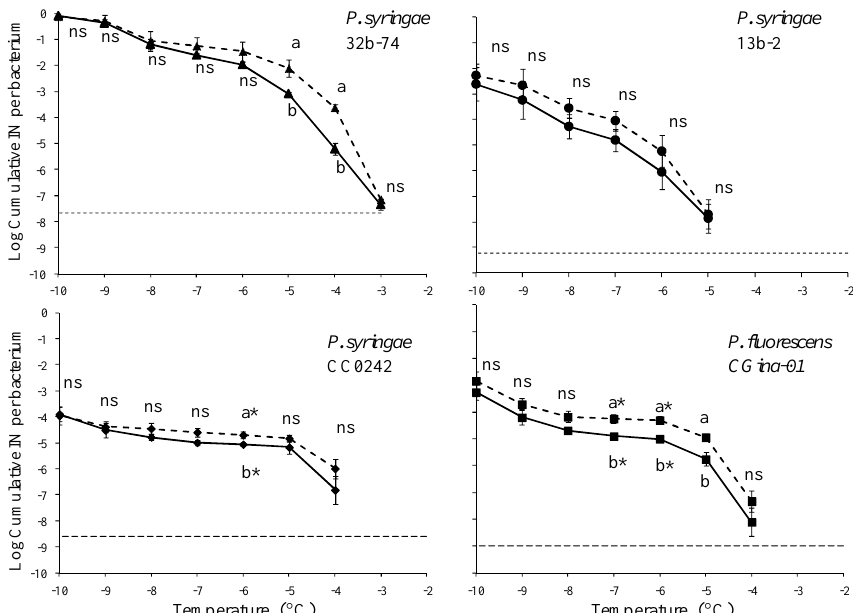
Fig. 5. Ice nucleation spectra of Pseudomonas strains submitted to 42h of UV-A exposure (solid line) or darkness (dotted line). The horizontal line corresponds to the lowest value of detectable activity, which depends on the initial bacterial concentration of each experiment. Symbols Figure 5: Ice nucleation spectra of Pseudomonas strains submitted to 42 h of UV-A exposure 3 are as in Fig. 1. INA was calculated by dividing the number of ice nuclei (IN) recorded after 42h of UV-exposure by the viable cell number counted at the beginning of the experiment. At each temperature, values associated with different letters are significantly different at p < 0.05 (solid line) or darkness (dotted line). The horizontal line corresponds to the lowest value of 4 and those associated with an asterisk are significantly different at p < 0.1 based on Tukey’s test. ns: no significant treatment effect. Errors detectable activity, which depends on the initial bacterial concentration of each experiment. 5 bars are standard errors ( n = 4). Symbols are as in Figure 1. INA was calculated by dividing the number of ice nuclei (IN) 6 living bacteria but also on the INA of the non-viable bac- recorded after 42 h of UV-exposure by the viable cell number counted at the beginning of the 7 terial product Snomax r , thereby supporting the hypothesis experiment. At each temperature, values associated with different letters are significantly 8 that acidic pH affects the INA of bacteria probably by di- rectly changing the ice nucleation protein structure. How- different at p<0.05 and those associated with an asterisk are significantly different at p<0.1 9 ever, the effects of acidic pH were less intense on Snomax r based on Tukey’s test. ns: no significant treatment effect. Errors bars are standard errors 10 than on living bacteria. This suggests that for living cells, (n=4). 11 acidic pH likely acts through a combination of direct changes of the ice nucleation protein structure and indirect effects via bacterial metabolism in reaction to acidic conditions. To more clearly specify the effects of pH on INA, we took into account the effect on water activity of the solutes used as buffer. Indeed, as shown previously (Zobrist et al., 2008; Koop and Zobrist, 2009) a reduction in water activity is linked to a reduction in the INA of dusts and Snomax r . All our data were corrected for water activity of the pH buffer but, when subjected to pH 5.9, the INA of some strains dif- fered more or less from that in distilled water. For Snomax r , a slight positive effect of this pH buffer on INA was observed. This increase is counterintuitive but could be linked to the complex nature of Snomax r which is a lyophilized product composed of bacteria but also culture medium residues and different wastes which can interact in a complex and still un- explained way with the pH